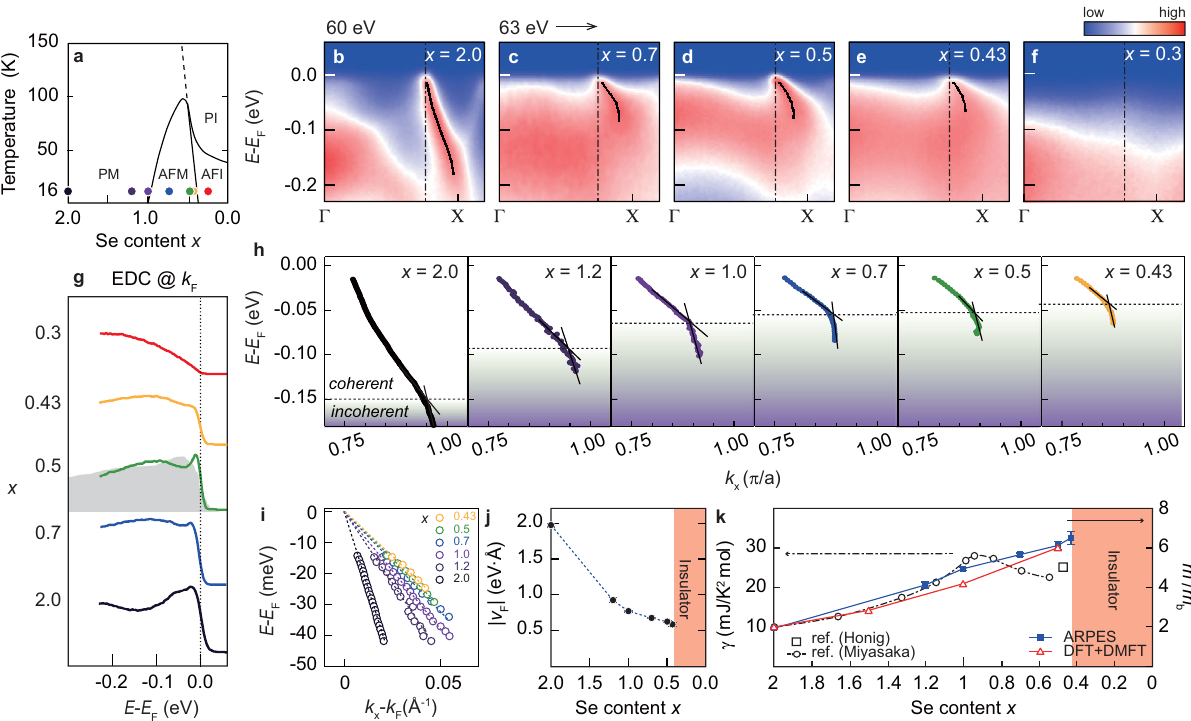
Fig. 2 Se content-dependent quasiparticle (QP) dispersion. a Phase diagram of NiS 2 − x Se x reproduced from ref. 15 . PM, PI, AFM, and AFI stand for paramagnetic metal, paramagnetic insulator, antiferromagnetic metal, and antiferromagnetic insulator, respectively. Small circles indicate where ARPES measurements were carried out. All data were taken at 16 K. b – f ARPES data along the Γ -X direction (see Supplementary Fig. 6 for x = 1.2 and 1.0 data). g Energy distribution curves (EDCs) at the Fermi momentum ( k F ) as represented by dash-dotted lines in panel ( b – f ). The QPs of previous APRES data was buried in incoherent band as depicted with gray fi lled curve 12 . In case of x = 0.3 data (Mott insulator), the EDC is from the same momentum as that of others. h QP dispersions obtained by fi tting the momentum distribution curves (MDCs). i – k Doping dependent α band dispersion, Fermi velocity v F , and effective mass m *, respectively. The linear coef fi cient of the speci fi c heat γ is also plotted for comparison 15,16 consistent with the calculated FS in the k z = 0 plane using DFT (dashed lines in Fig. 1a, b). One can easily see a large hole pocket α centered at the Γ point and δ 1,2 bands near the M point. These symmetry cuts (along the green line in Fig. 1a) as shown in Fig. 1c. Other than the hole-like surface band ζ observed around Γ point in ARPES data (see Supplementary Note 2), the DFT band structure of Ni e g orbitals (dotted lines in Fig. 1c) renormalized by the factor 1.99 is consistent with ARPES data near the Fermi level.